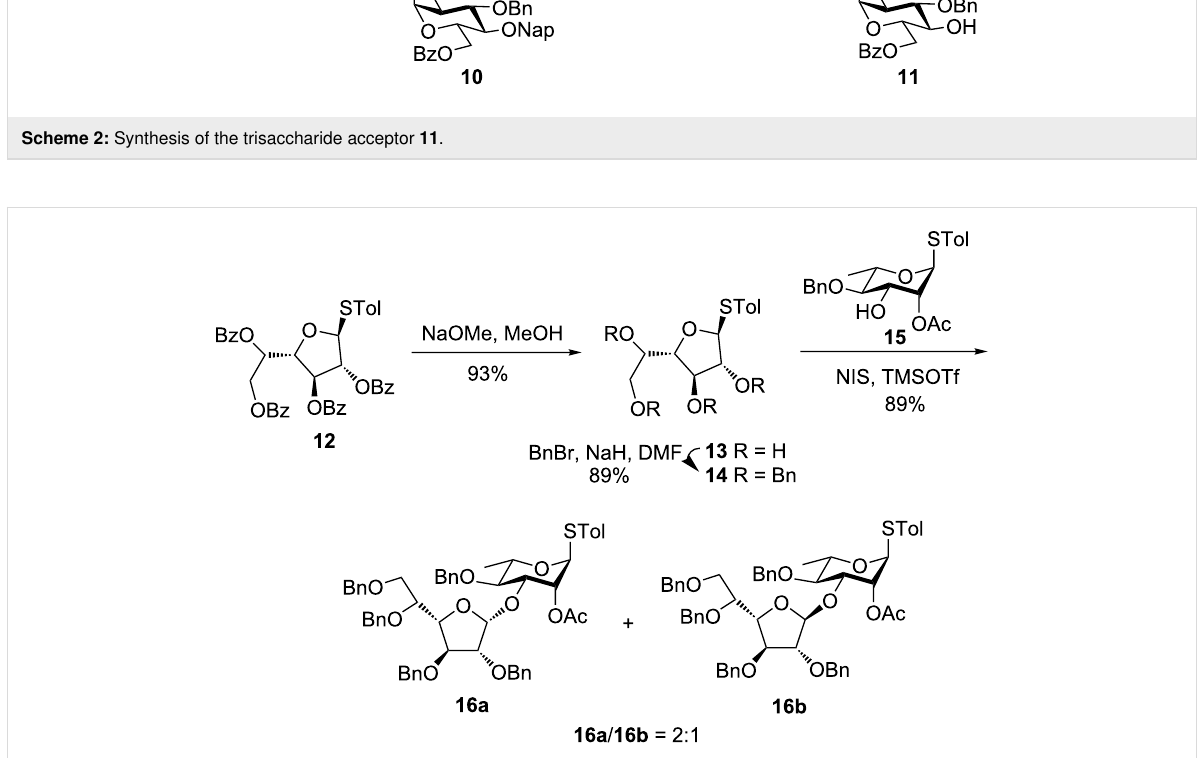
Scheme 3: Synthesis of the non-reducing end disaccharides ( 16a and 16b